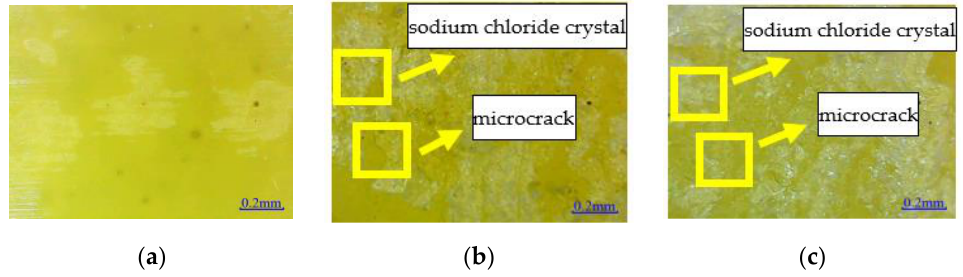
Figure 12. Microstructure: ( a ) EPND; ( b ) EPSI-400; and ( c ) EPSF-100.